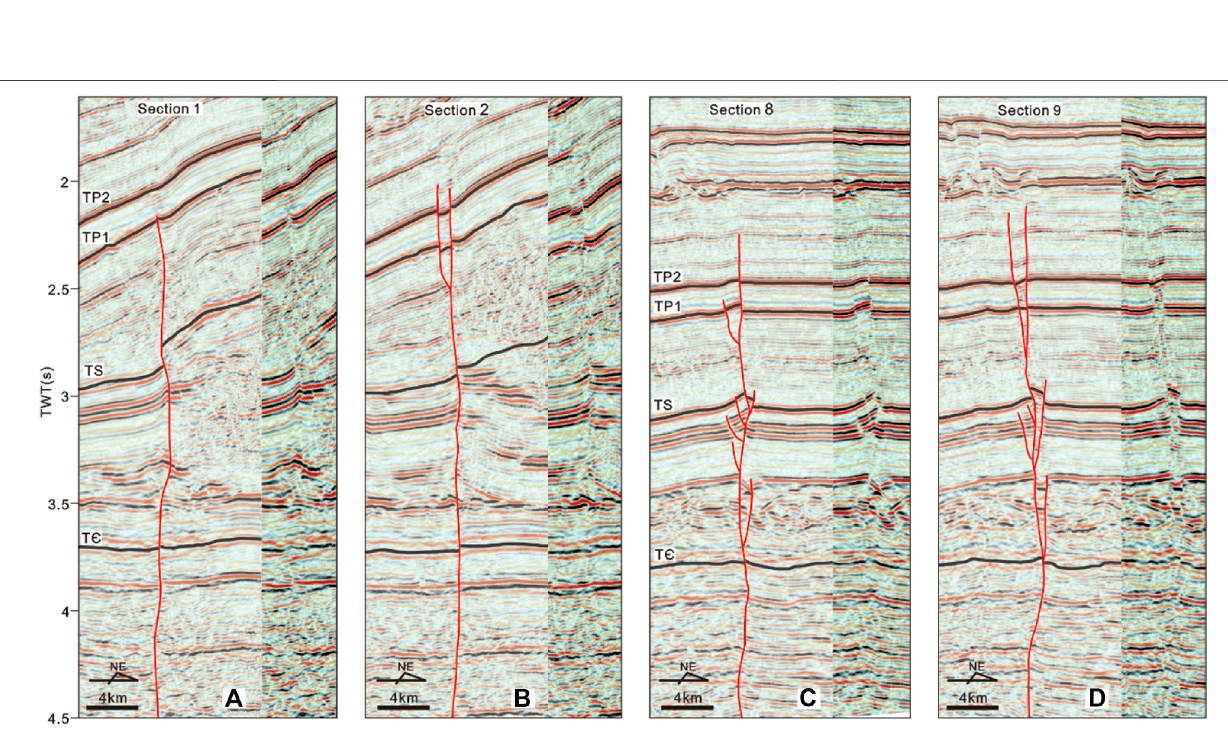
Frontiers in Earth Science |